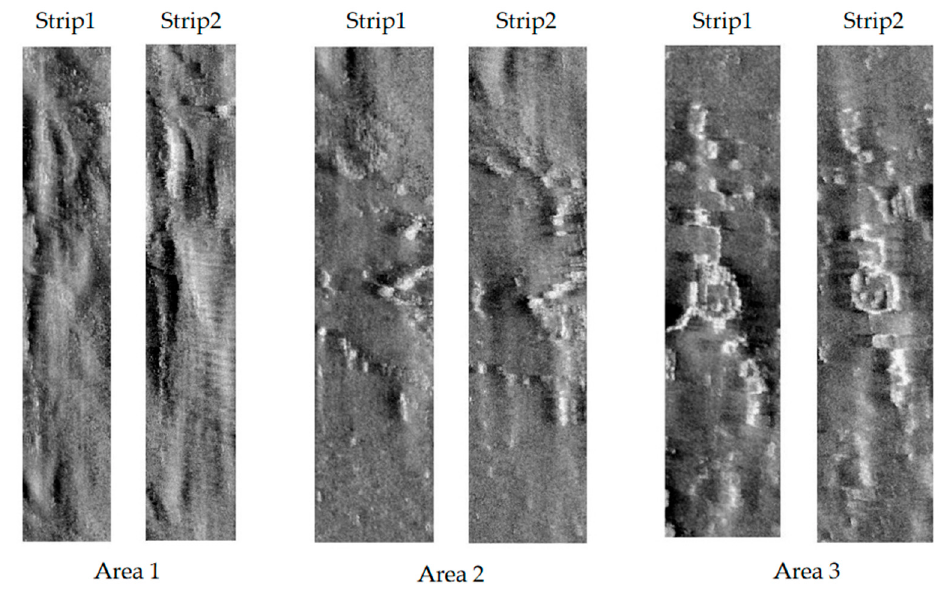
Figure 5. Selected fusion areas. Table 1. Structure of Curvelet transform coefficients.